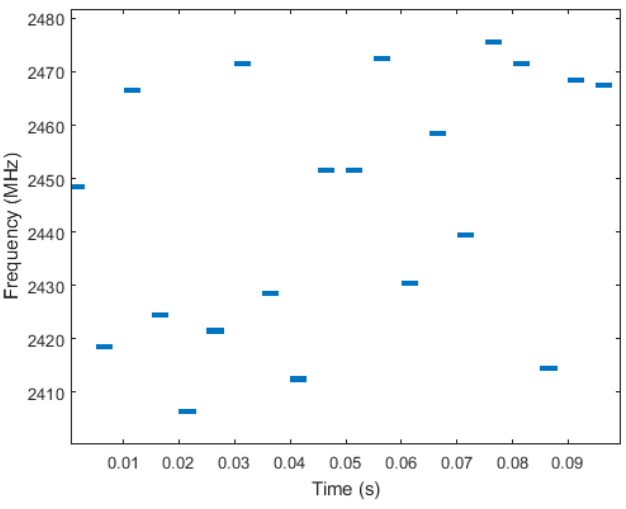
Figure 1. Example of a Frequency Hopping schedule.